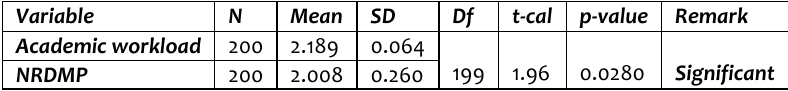
Table 2 : t-test summary on the academic workload for numerical reasoning